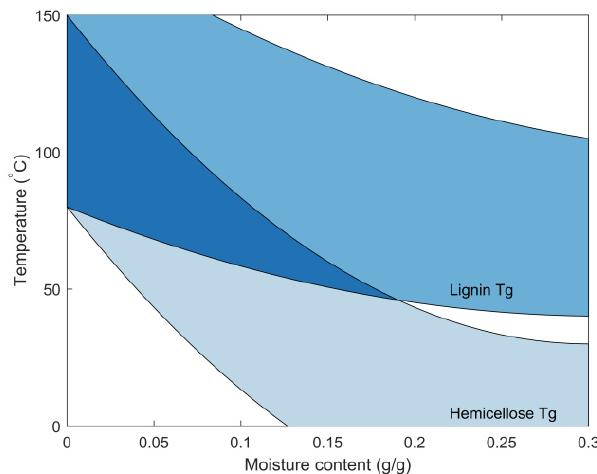
Figure 6. Glass transition temperature of hemicelluloses and lignin as a function of wood moisture content, based on [100–105].